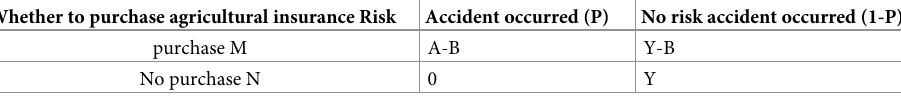
Table 1. Income probability distribution of farmers buying and not buying agricultural insurance when risks occur and when they do not occur. Whether to purchase agricultural insurance Risk Accident occurred (P) No risk accident occurred (1-P) purchase M A-B Y-B No purchase N 0